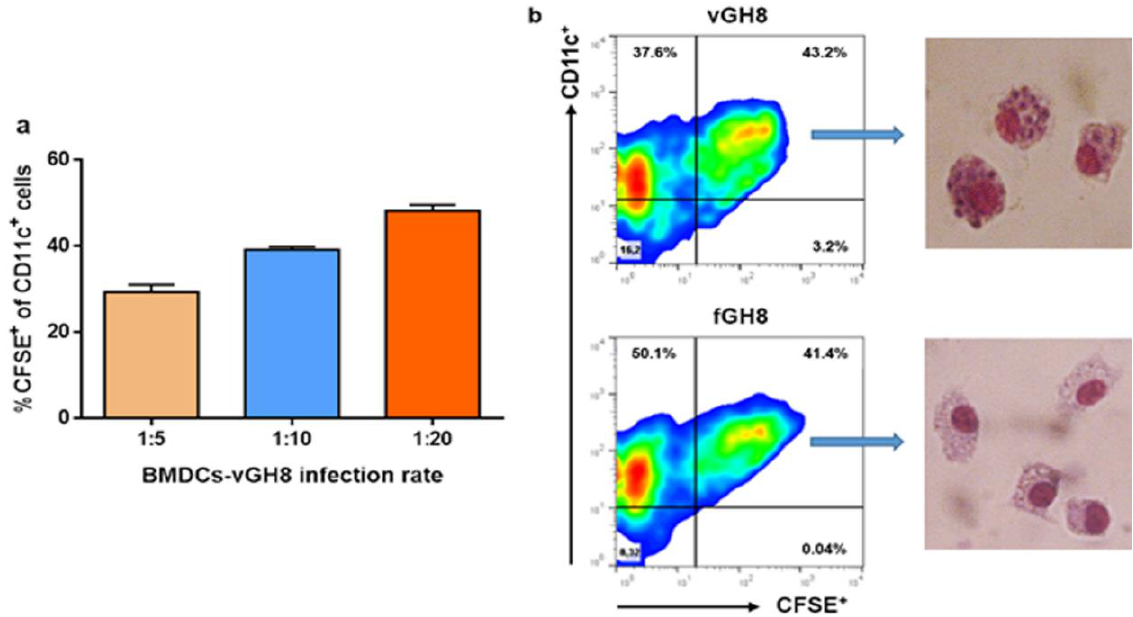
Figure 1. Evaluation of BMDCs’ ability to internalize the promastigote form of L. infantum parasites: ( a ) L. infantum promastigotes stained with CFSE were added to BMDCs in vitro cultures at different infection ratios, i.e., 1:5, 1:10, 1:20 and sampled at 24 h in order to assess the best ratio by flow cy- tometry analyses. Percentages of CFSE + BMDCs were estimated. The mean ± SD of three independ- ent experiments is shown. ( b ) Representative flow cytometry analyses plots at infection ratio of 1:20 for L. infantum -infected and fixed parasite-harboring BMDCs are shown with the respective Giemsa- stained microscopic analyses in the selected populations.